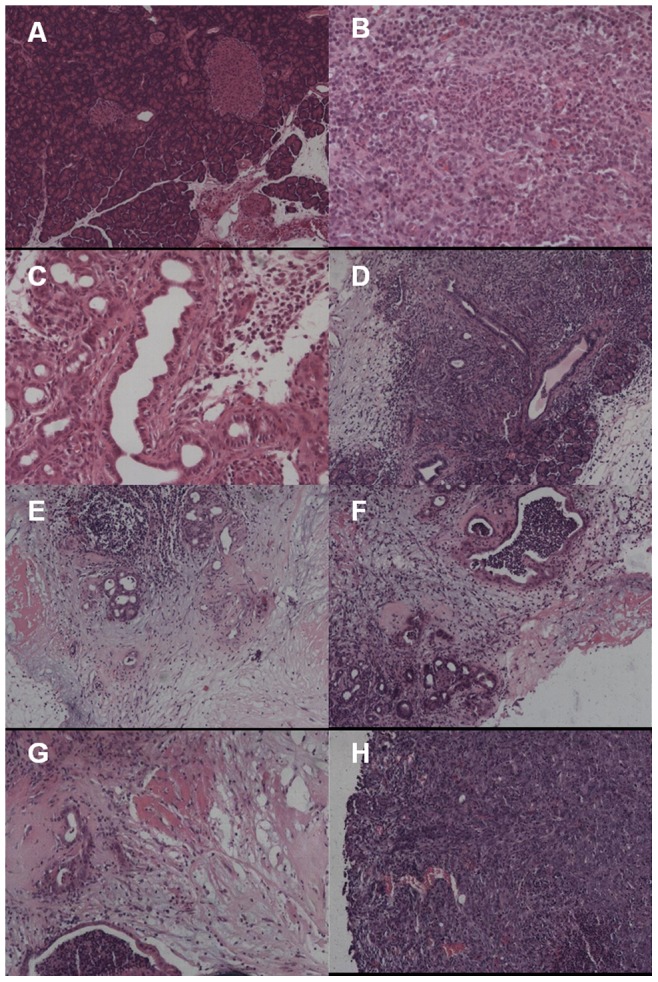
Histological changes in different stages of the DMBA-induced PC rat model.(A) Normal pancreas (original magnification ×60). (B) Acute pancreatitis (original magnification ×150). (C) Chronic pancreatitis (original magnification ×150). (D) PanIN 1a (original magnification ×60). (E) PanIN 2 (original magnification ×150). (F) PanIN 3 (original magnification ×60). (G) Well-differentiated PC (original magnification ×60). (H) Poorly-differentiated PC (original magnification ×60).